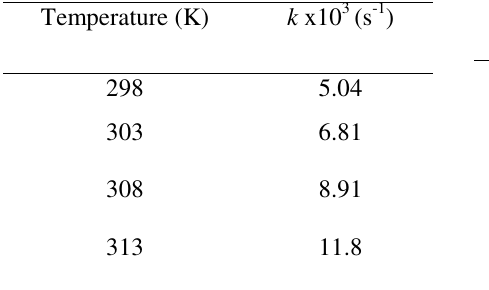
Table 2. Thermodynamic activation parameters for the oxidation of Paracetamol by DPA in aqueous alkaline medium with respect to the slow step of Scheme 1 (A) Effect of